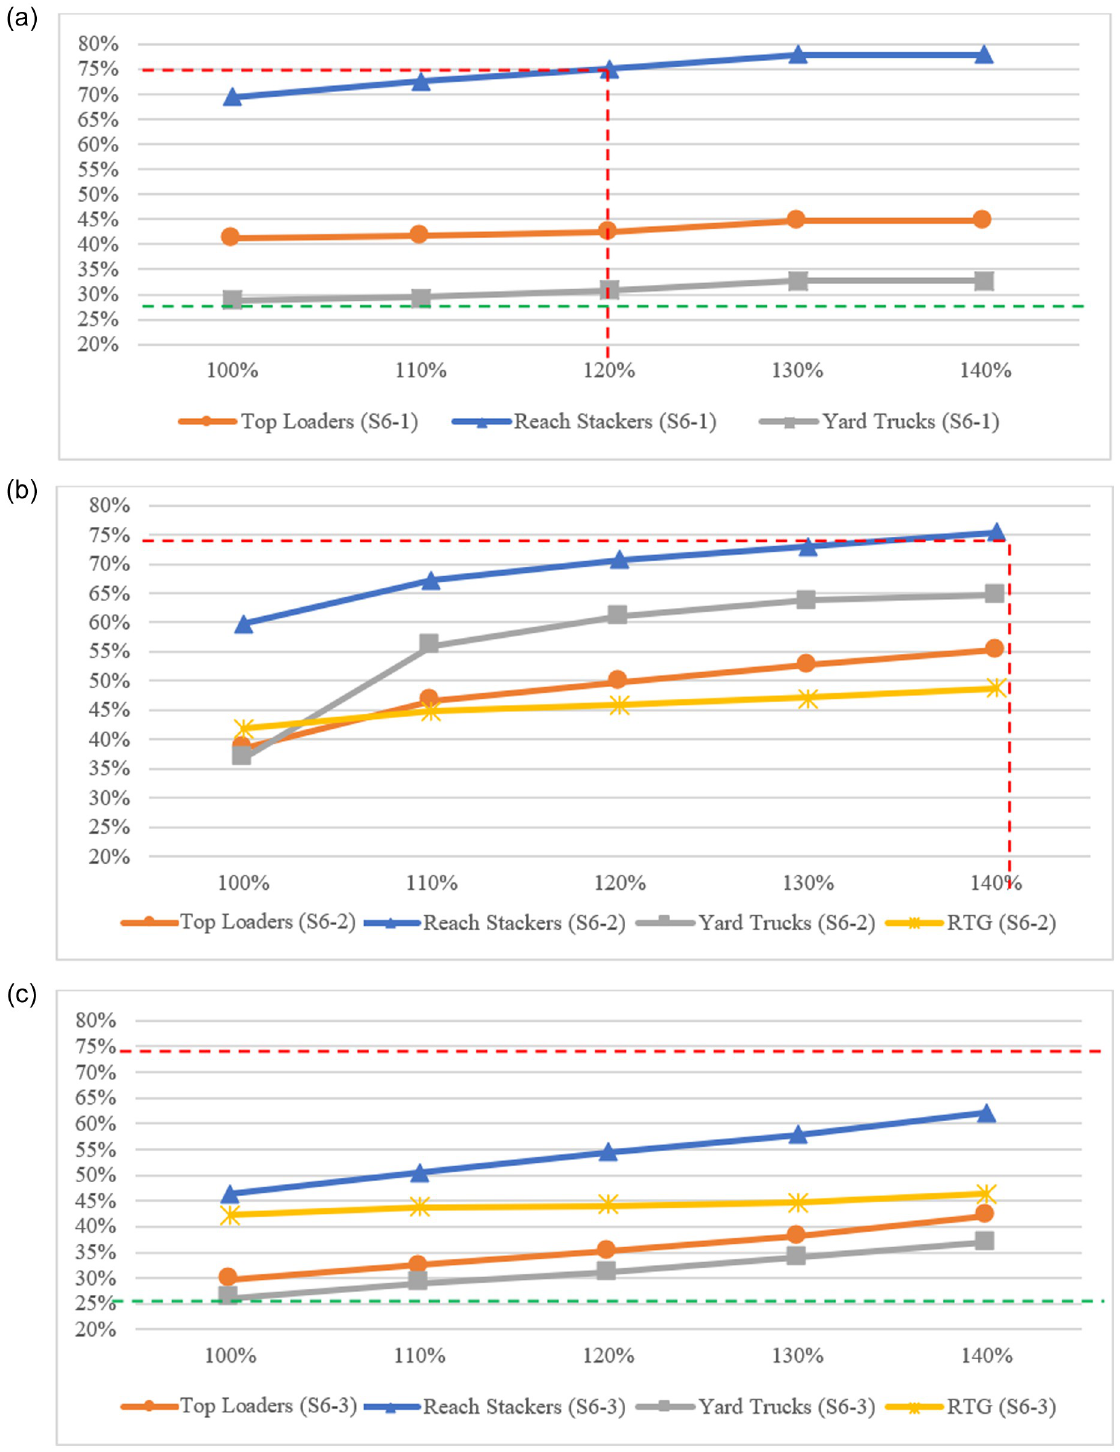
Fig 10. CHE utilization of scenarios S6-1 to S6-3. (a) CHE utilization in scenario S3 with incremental container demands (scenario S6-1). (b) CHE utilization in scenario S4 with incremental container demands (scenario S6-2). (c) CHE utilization in scenario S5 with incremental container demands (scenario